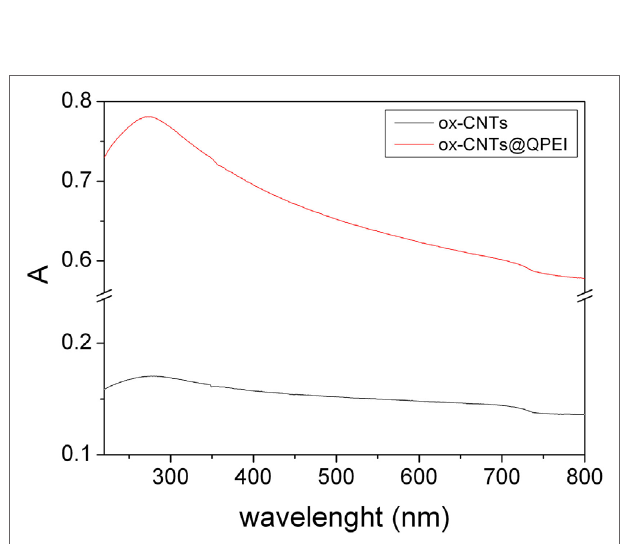
FigUre 4 | UV–vis absorption spectra of oxidised­carbon nanotubes (ox­CNTs) (black) and ox­CNTs@QPEI (red), in aqueous solution (1 mg mL − 1